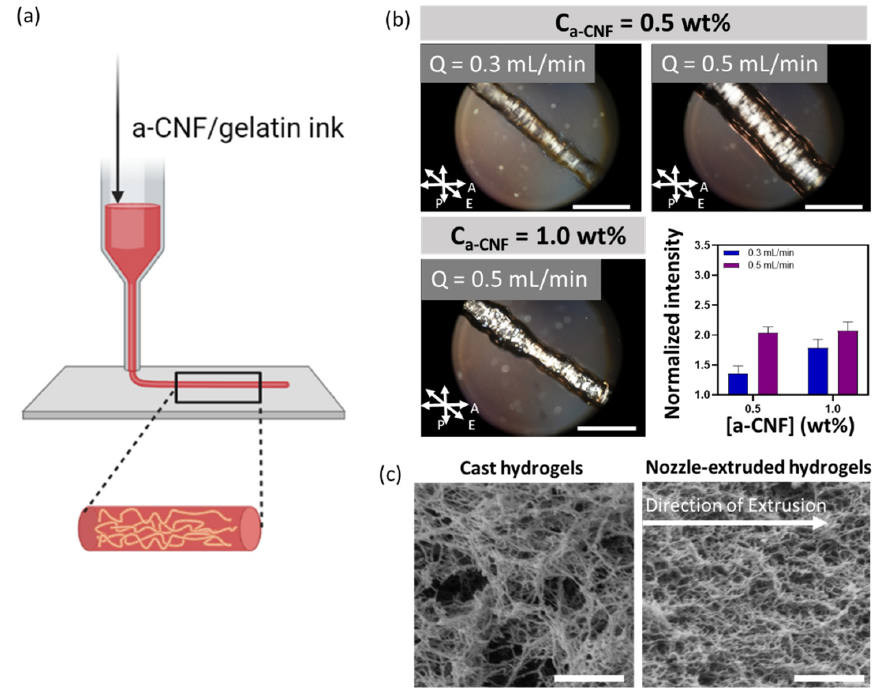
Figure 4. Structurally anisotropic hydrogel threads extruded through a nozzle. ( a ) Schematic depicting printing of hydrogel threads. ( b ) POM images of the extruded hydrogel threads at C gelatin = 4.0 wt.%. Top left: C a-CNF = 0.50 wt.%, Q = 0.3 mL/min. Top right: C a-CNF = 0.50 wt.%, Q = 0.5 mL/min. Bottom left: C a-CNF = 1.0 wt.%, Q = 0.5 mL/min. Scale bars are 2 mm. Bottom right: Average light intensity of the extruded hydrogel thread, normalized to that of the cast hydrogel with the same composition. Each bar represents three independently examined hydrogels. The arrows in the image depict the direction of extrusion (E) and the direction of the polarizer (P) and analyzer (A) with respect to the direction of extrusion. ( c ) SEM images of the cast (left) and extruded hydrogel threads (right). The gel was extruded at Q = 0.5 mL/min. C a-CNF = 1.0 wt.%; C gelatin = 4.0 wt.%. Scale bars are 1 μ m.